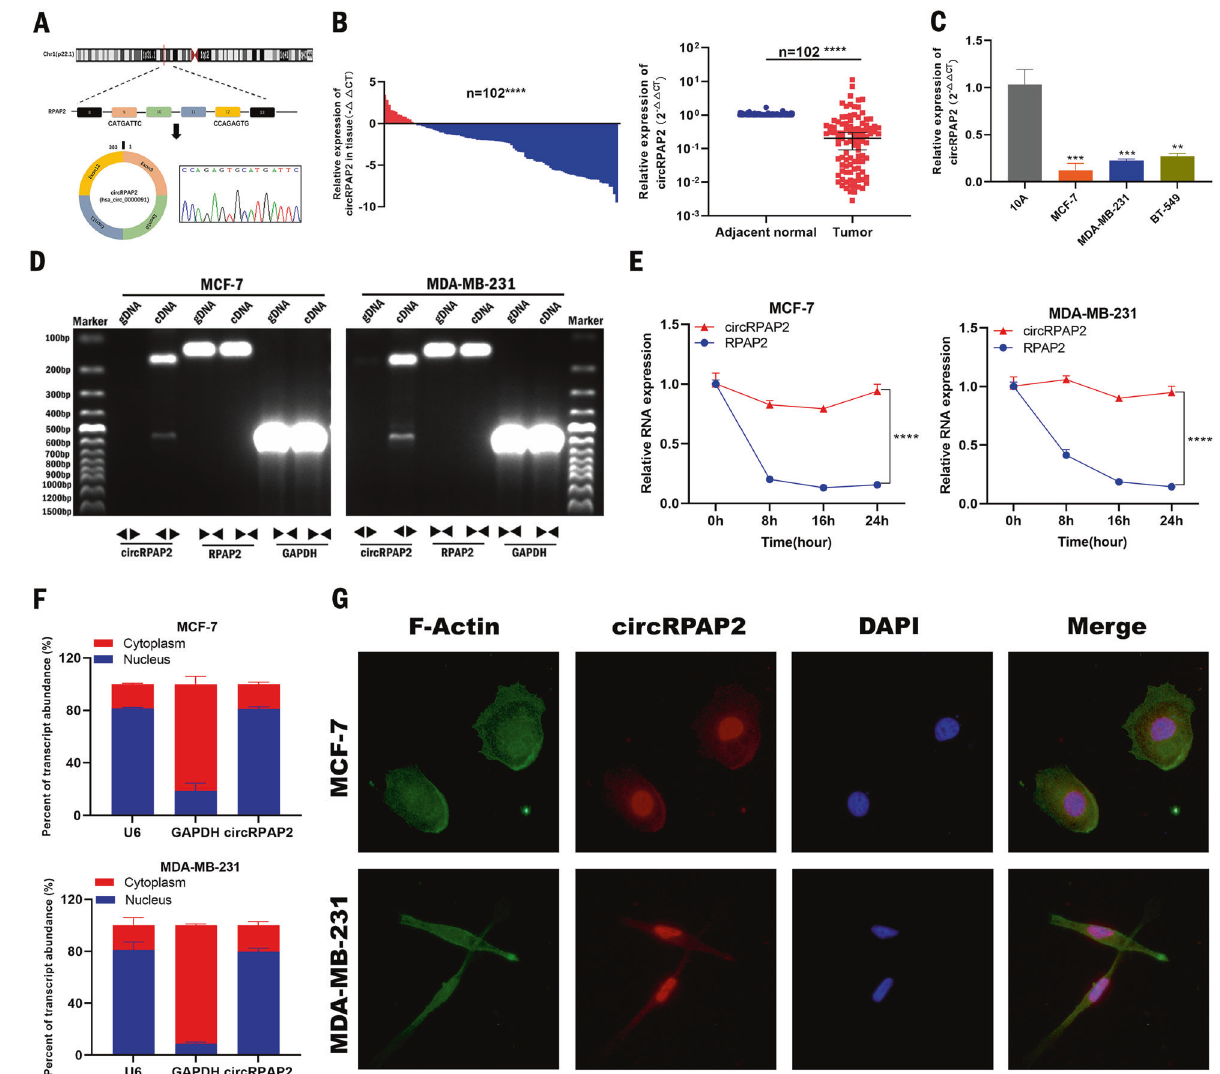
Fig. 1 Characteristics of circRPAP2 in BC. A The structure of circRPAP2 (hsa_circ_0000091) and the splicing junction of circRPAP2 was veri fi ed by Sanger sequencing B Level of circRPAP2 in BC tissues compared with that in the adjacent normal tissues ( n = 102) as determined by qRT- PCR. C Level of circRPAP2 in BC cell lines. D and E The existence of circRPAP2 in BC cells was veri fi ed using agarose gel electrophoresis and actinomycin D assays. F Localization of circRPAP2 in BC cells as detected using the cytoplasm – nucleus separation assay. G Localization of circRPAP2 in BC cells as detected by RNA FISH. (* P < 0.05, ** P < 0.01, *** P < 0.001, **** P <